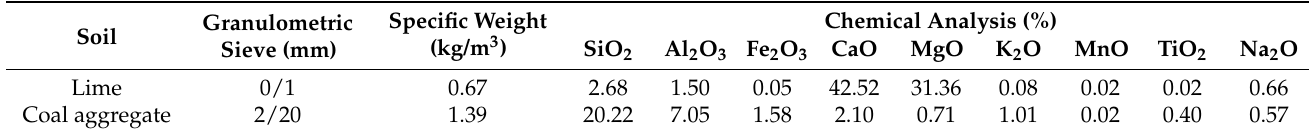
Figure 8. The eight studied CEB Formulations. Table 3. Formulations composition. Raw Earth